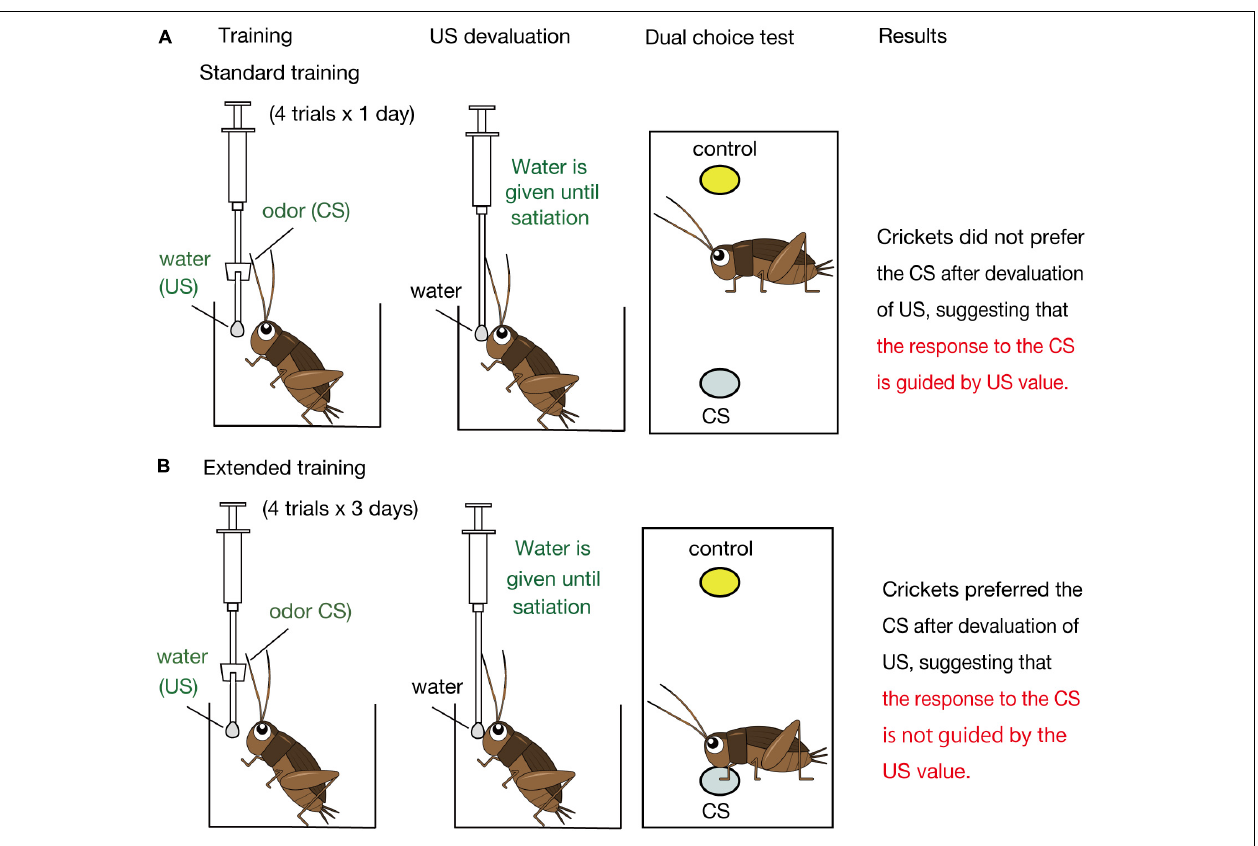
FIGURE 2 | Schematic illustration of the effects of US devaluation on execution of a CR after standard (A) and extended (B) Pavlovian training in crickets. Crickets that had received standard training (4-trial × 1-day training) or extended training (4-trial × 3-day training) to associate an odor CS with water US were given water until they stopped drinking prior to the post-training test (Mizunami et al., 2019). In the test, crickets that had received standard training exhibited no significant preference for the CS over a control odor (i.e., did not spend a significantly longer time for exploring at the CS odor source than at the control odor source), whereas crickets that had received extended training exhibited a significant preference for the CS over the control odor (i.e., spent a significantly longer time for exploring at the CS odor source), as did control crickets that received no US devaluation before the